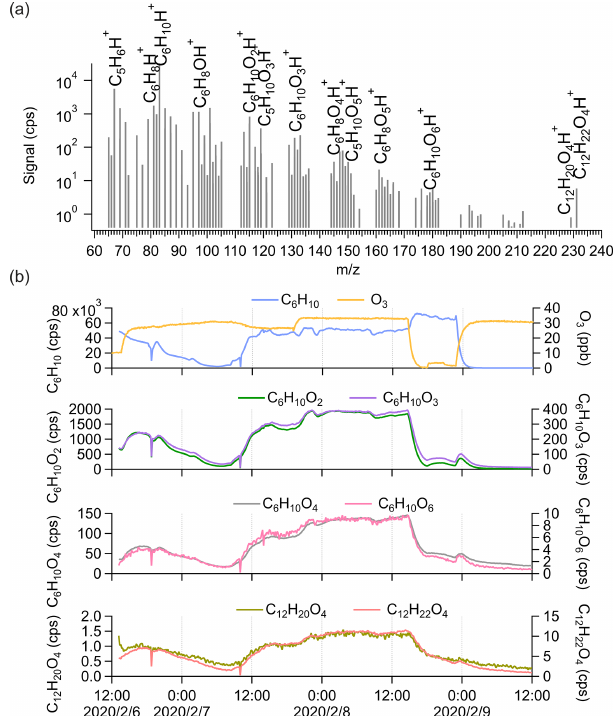
Figure 3. (a) The average mass spectrum of Vocus PTR-TOF measurements from cyclohexene ozonolysis. The peaks of cy- clohexene, its major fragments inside the Vocus PTR-TOF, and some cyclohexene oxidation products are labelled. (b) Time series of cyclohexene (C 6 H 10 ), O 3 , cyclohexene monomers (C 6 H 10 O 2 , C 6 H 10 O 3 , C 6 H 10 O 4 , and C 6 H 10 O 6 ), and potential cyclohexene dimers (C 12 H 20 O 4 and C 12 H 22 O 4 ) during the experiment. The cy- clohexene signals were varied by changing the